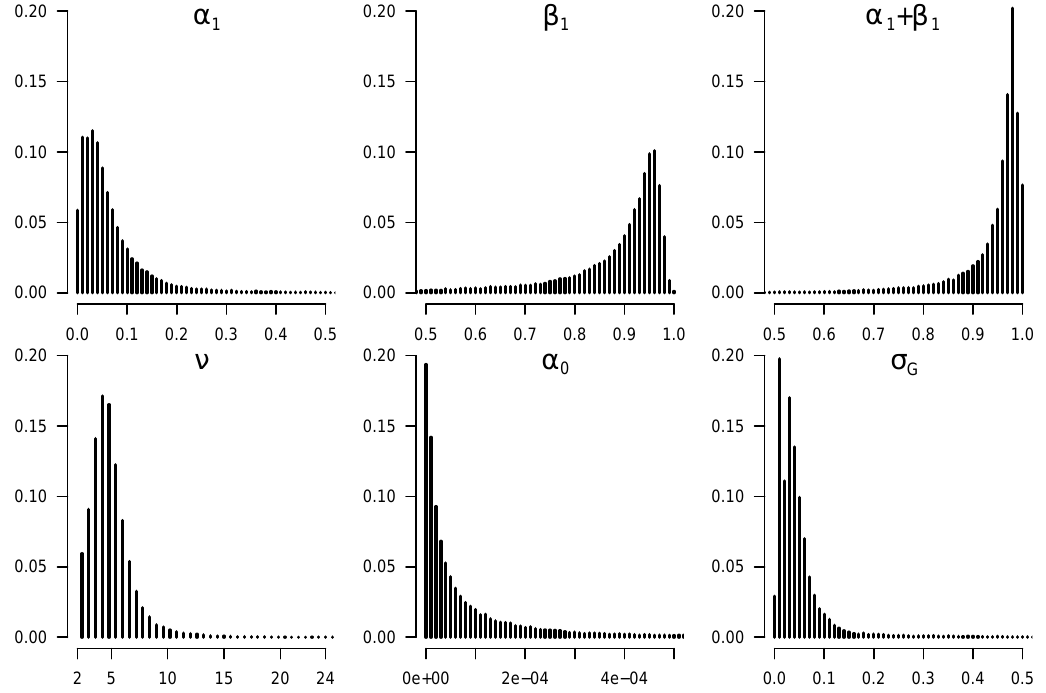
Figure 2. Distribution of parameter estimates, when fitting AR(1)-GARCH(1,1) models to the 41,069 sets of cointegration residuals between the DAX 30 constituents identified on 249 trading days in